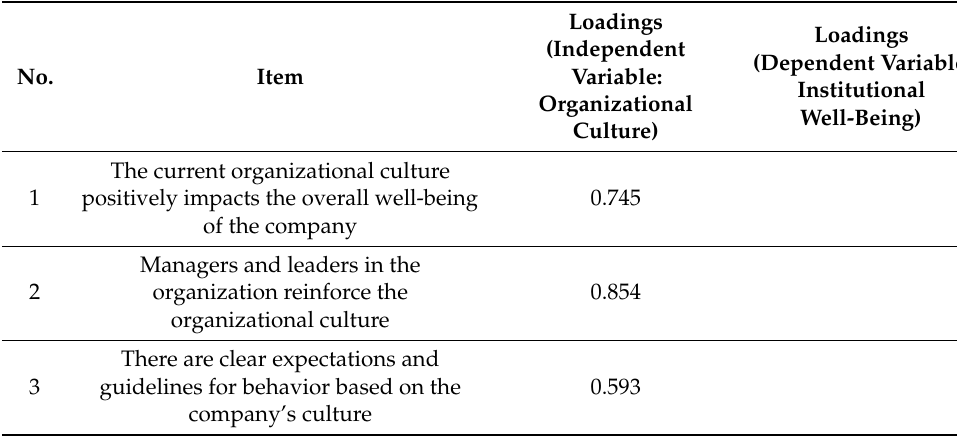
Table 2. The results of the exploratory factor analysis of the study tool.